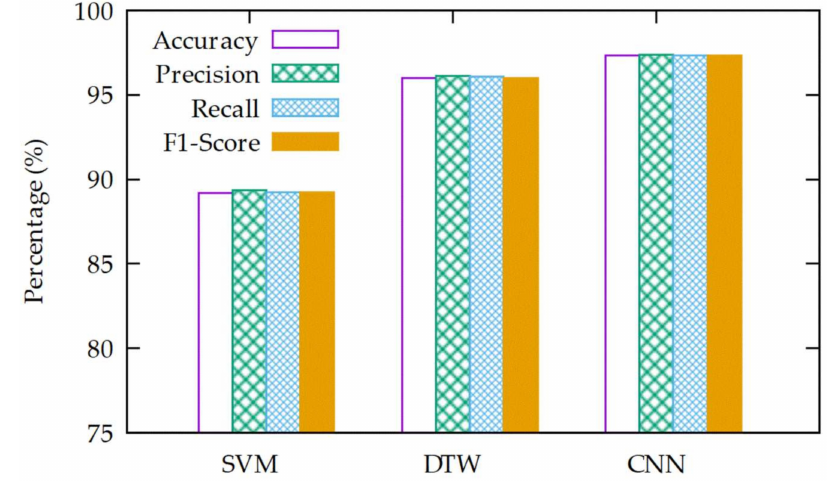
Figure 7. The results of the various